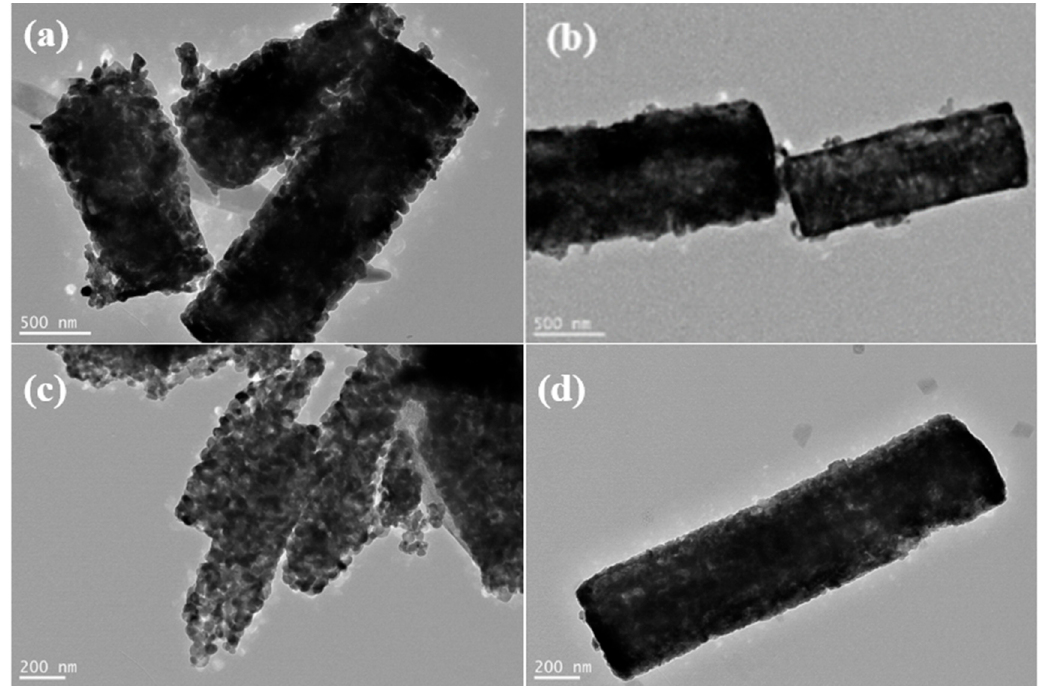
Figure 6. TEM images of ( a ) MgTiO 3 , ( b ) CoTiO 3 , ( c ) NiTiO 3 , and ( d ) ZnTiO 3 after annealing process.